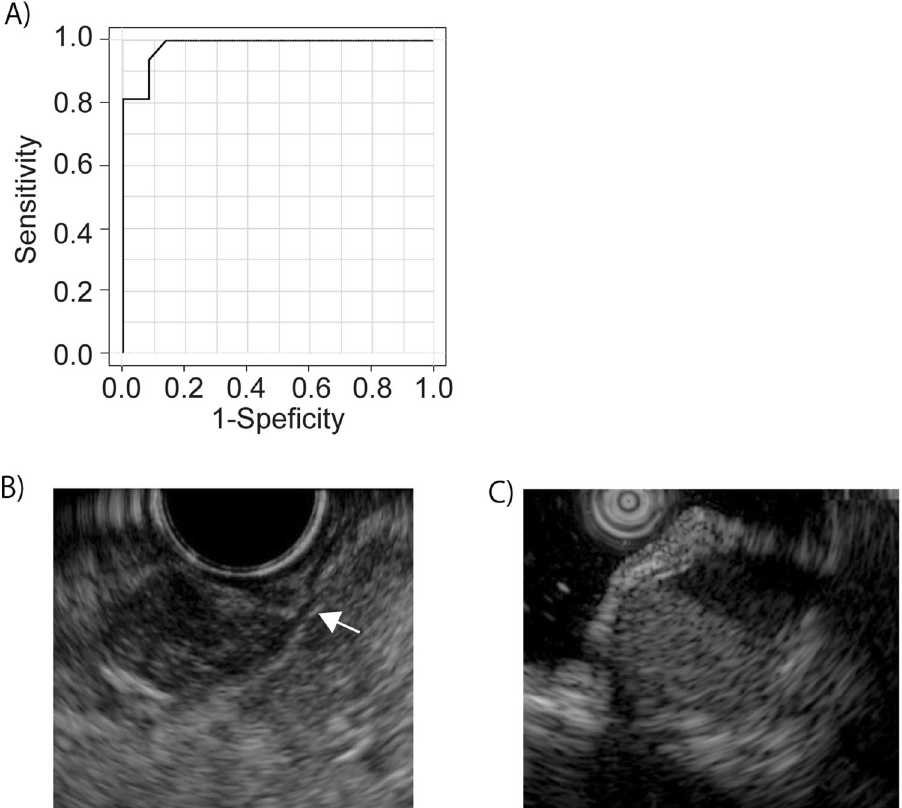
Figure 1. Diagnostic ability of EUS-AI. ( A ) The receiver operating characteristic curve for the diagnostic ability of EUS-AI for non-gastric GISTs is shown. Fifty-two patients with non-gastric SELs were analyzed using EUS-AI. For each case, a diagnosis of GIST or non-GIST was made, and the probability of GIST was evaluated. ( B ) EUS image of a duodenal aberrant pancreas, which was misdiagnosed as GIST by EUS-AI. The lesion was judged to originate from the muscle layer (white arrow). ( C ) EUS image of colonic appendiceal mucosal retention, which was misdiagnosed as GIST by EUS-AI. EUS-AI, endoscopic ultrasound-based artificial intelligence; GIST, gastrointestinal stromal tumors; SEL, subepithelial